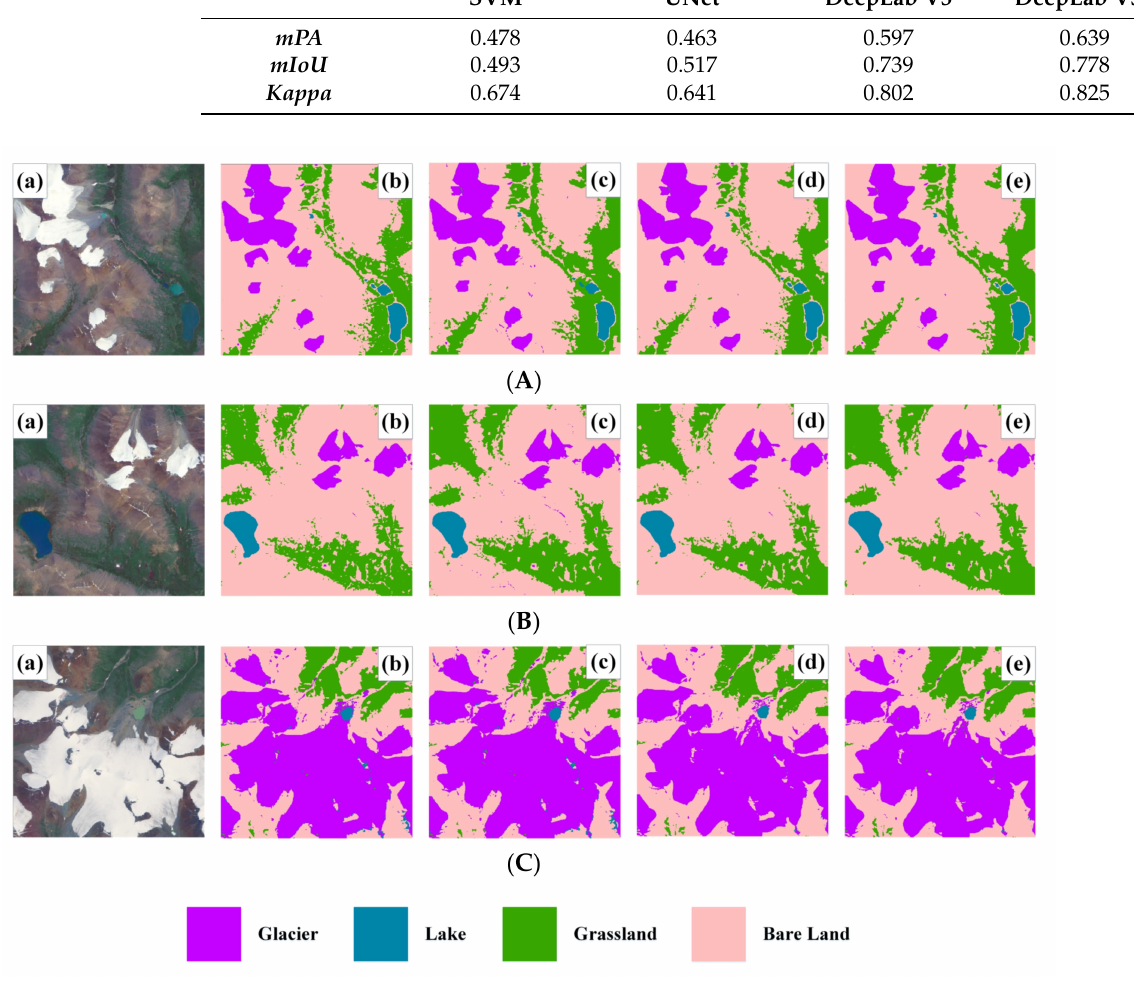
Figure 8. The extraction results of eco-environment elements. ( a ) The raw image; ( b ) SVM; ( c ) UNet; ( d ) DeepLab V3; ( e ) DeepLab V3+. Where ( A – C ) represent the three typical regions of the headwaters of the Yangtze